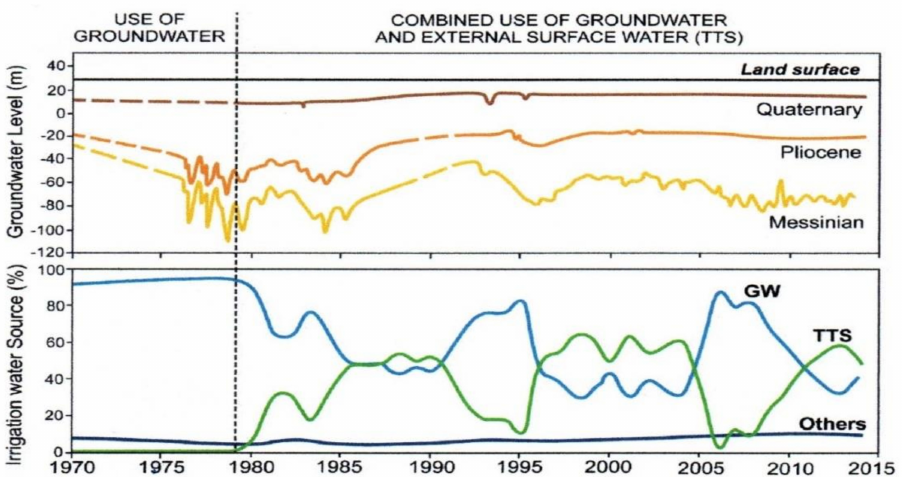
Figure 2. Evolution of groundwater levels with irrigation-water source in layered Campo de Carta- gena aquifer system (Murcia) Spain. GW—local groundwater resources; TTS—surface-water transfer from the Tajo to Segura